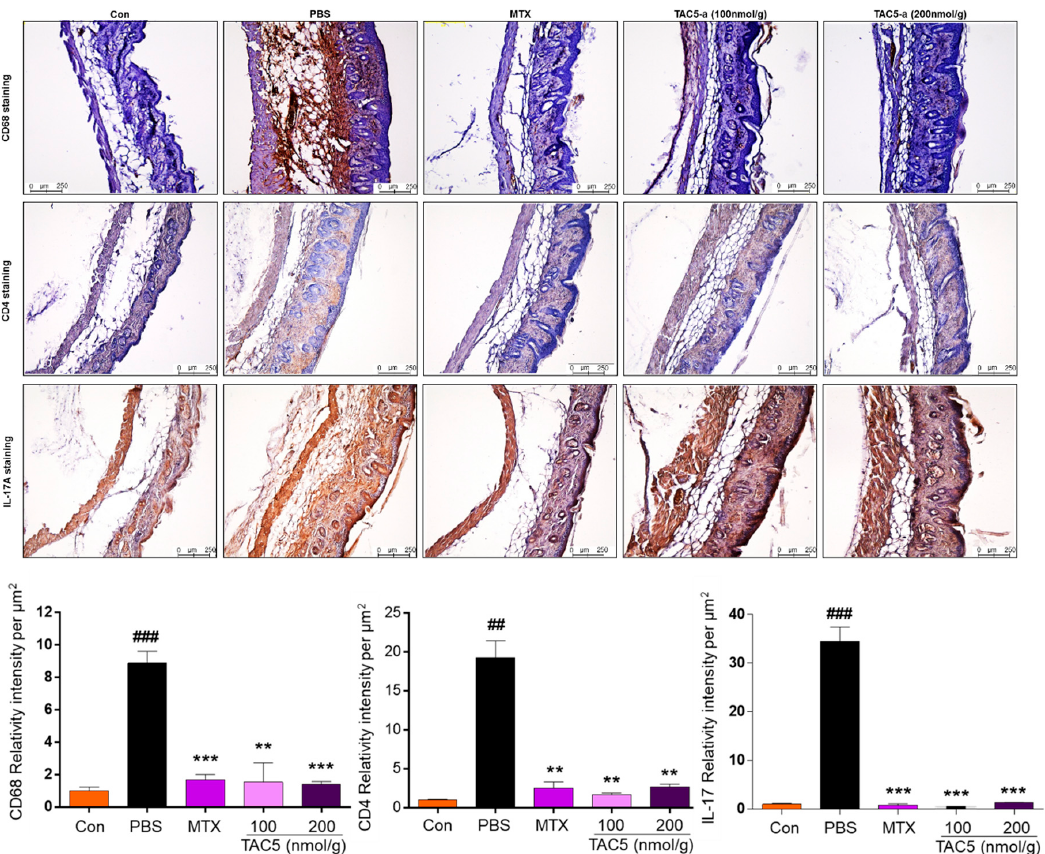
Figure 5. Immunohistochemical analysis of the back skin lesions of each group. The Figure5. Immunohistochemicalanalysisofthebackskinlesionsofeachgroup. Theimmunohistochemistry immunohistochemistry evaluation was performed by using primary antibodies recognizing CD68. evaluation was performed by using primary antibodies recognizing CD68. TAC5-a e ff ectively decreased TAC5-a effectively decreased the expression of CD68, CD4, and IL-17A (brown). Data represent mean ± the expression of CD68, CD4, and IL-17A (brown). Data represent mean ± SEM from five skin tissues SEM from five skin tissues of each group by two-tailed Student’s t -test, ### p < 0.001, * p > 0.01, * p > 0.05. of each group by two-tailed Student’s t -test, ## p < 0.01, ### p < 0.001, ** p < 0.01, *** p < The therapeutic potential of TAC5-a against systemic autoimmunity was further studied using MRL/lpr mice by intraperitoneally injecting daily doses of 10 nmol/g of TAC5-a (dissolved in 1% dimethyl sulfoxide [DMSO]) for 11 days. The inhibitor affected mice lymphoproliferation; lymphoid expansion was significantly prevented in the TAC5-a-treated mice as compared to that in vehicle- treated mice (Figure 6A). The production of anti-dsDNA autoantibodies remained low (Figure 6B), and the serum antinuclear antibodies (ANAs) were decreased by treatment with the inhibitor (Figure 6C). The detection of certain proteins, albumin in particular, in the urine serves as the marker of renal